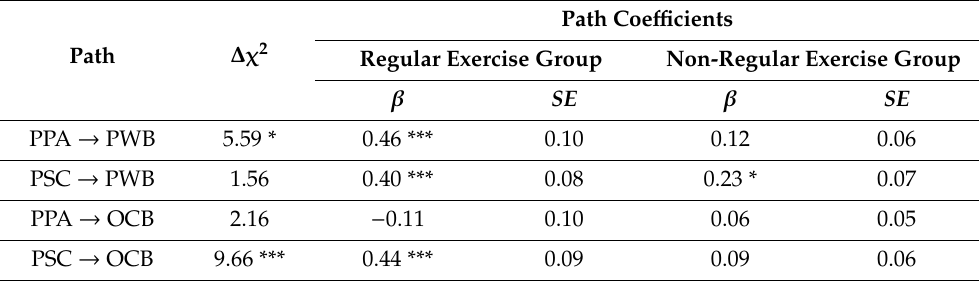
Table 5. The Results of moderating e ff ects of leisure-time physical activity. Path Coe ffi cients Path ∆ χ 2 Regular Exercise Group Non-Regular Exercise Group